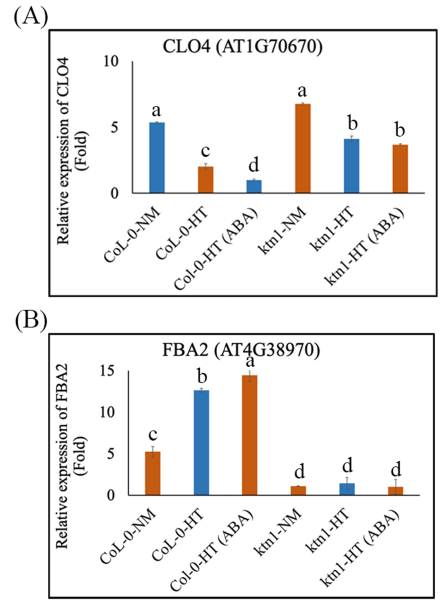
Figure 5. Relative gene expression values of ABA-related genes in roots of Col-0 and the ktn1 mutant upon the hydrotropism assay ( A ) Relative gene expression values of CLO4 (AT1G70670, a negative regulator in ABA signaling) in Col-0-NM, Col-0-HT, Col-0-HT (ABA), ktn1 -NM, ktn1 -HT, and ktn1 -HT (ABA). ( B ) Relative gene expression values of FBA2 (AT4G38970, a positive regulator in ABA signaling) in Col-0-NM, Col-0-HT, Col-0-HT (ABA), ktn1 -NM, ktn1 -HT, and ktn1 -HT (ABA). The values are means, and error bars show ± SE of four technical replicates from three independent experiments ( n = 12). Values with the same letters were not significantly different from one another (one-way ANOVA, p < 0.05).